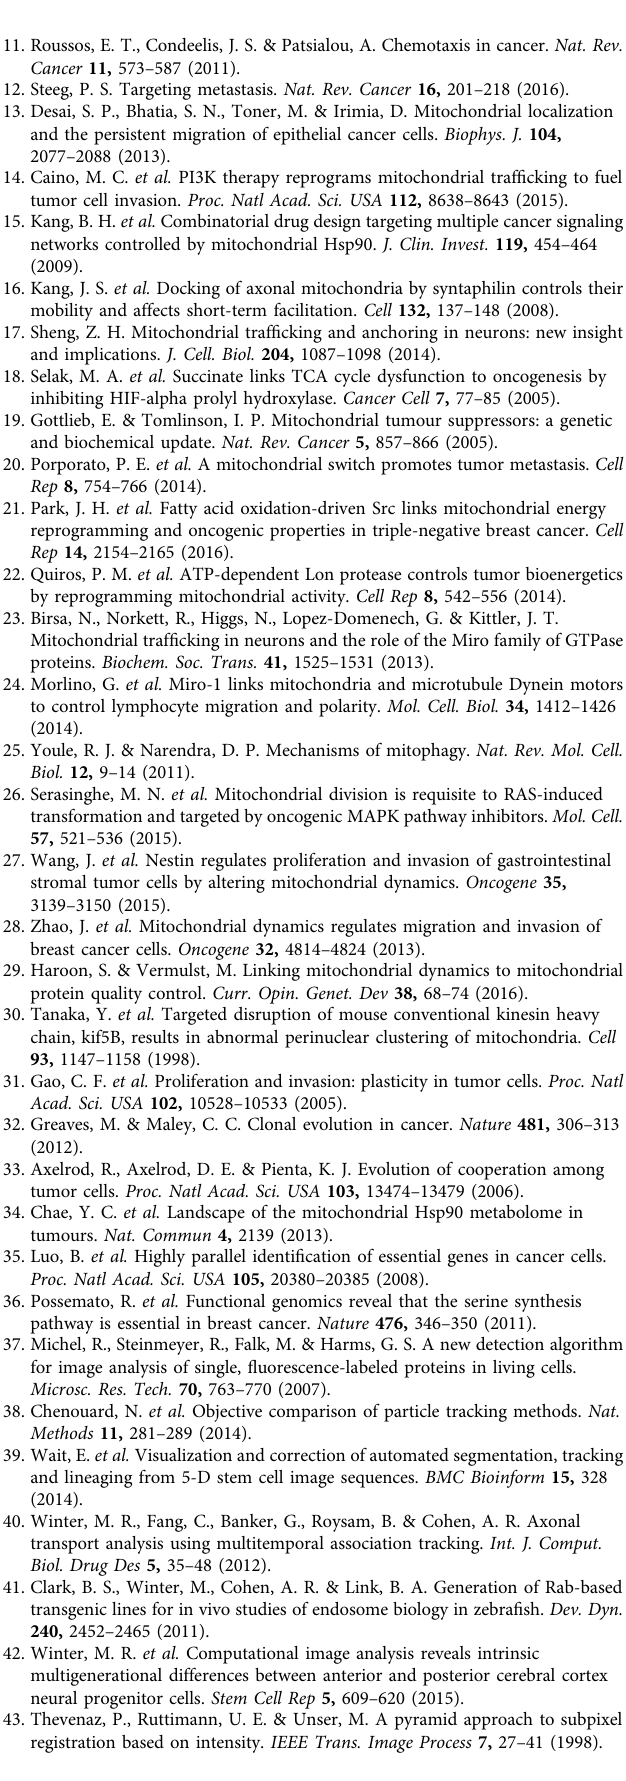
Supplementary Table 2. Breast cancer metastatic burden to lymph nodes was calculated as the proportion of metastatic nonsentinel lymph nodes over the total number of analysed lymph nodes. The value of 10% was chosen as cutoff for high metastatic burden (Met LN 4 10%). Breast cancer molecular subtypes were determined by IHC assays of ER, PR, HER2 and Ki67 markers performed at diagnosis following the 2011 St